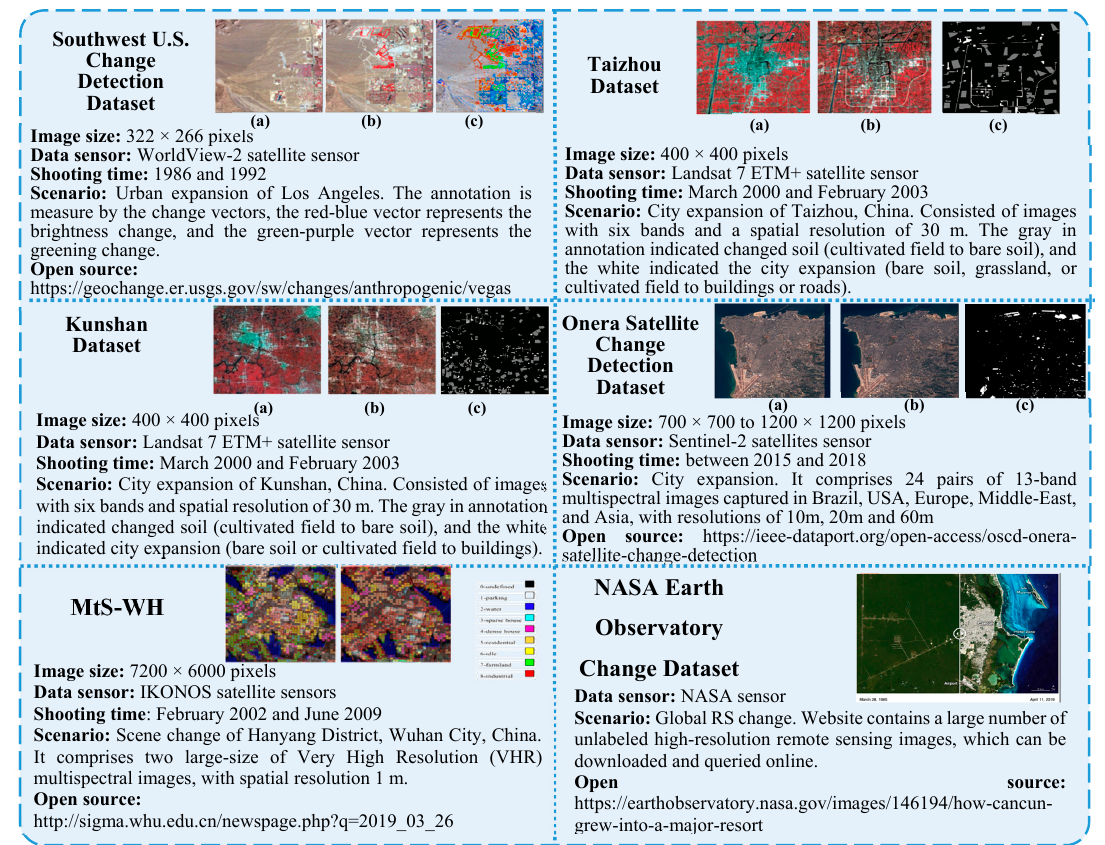
Figure 5. Dataset introduction of multispectral images in wide-area applications.